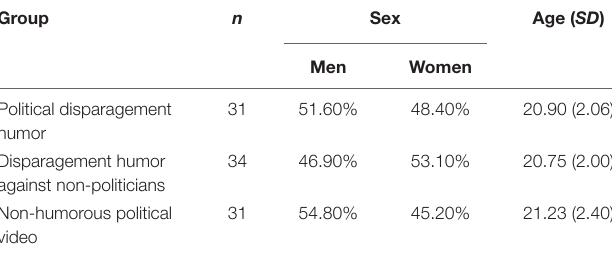
TABLE 1 | Sex and age descriptive statistics for the three groups.